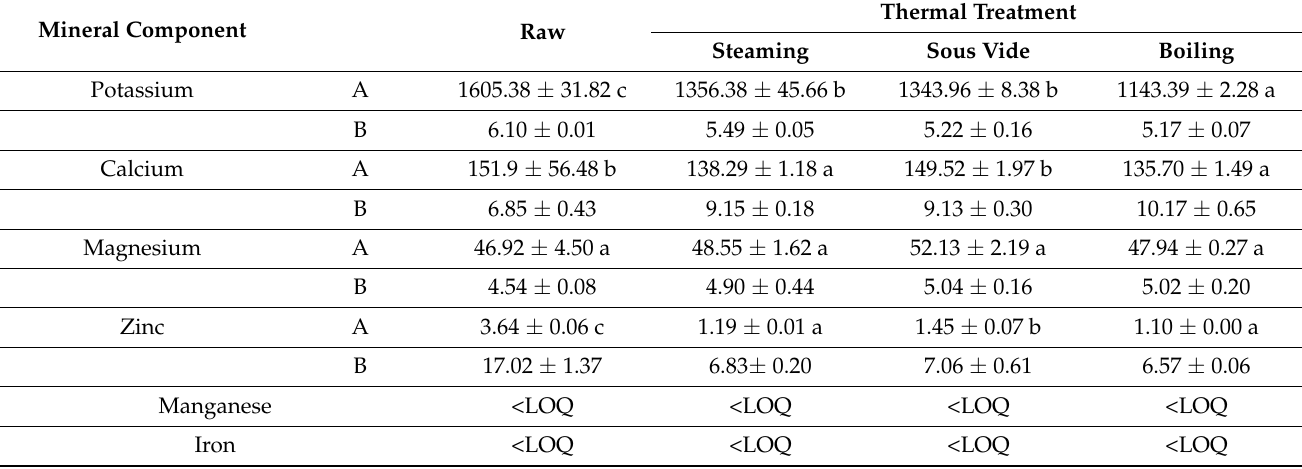
Table 5. Content of selected mineral components in raw and thermally treated Brussels sprouts after in vitro digestion (mg/kg